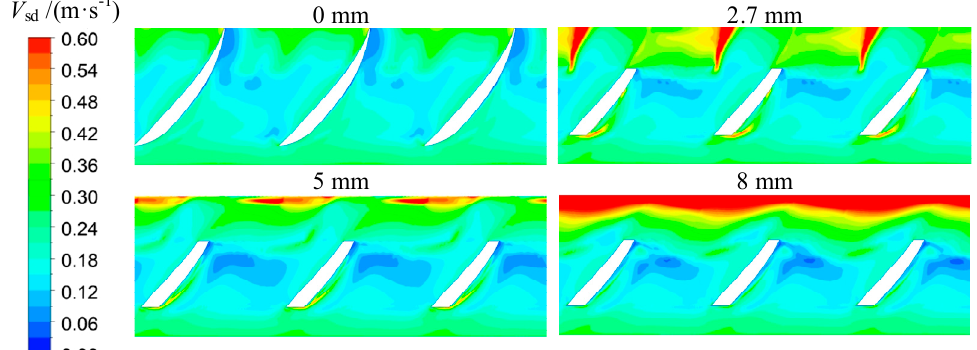
Figure 14. Standard deviation of the velocity distribution at Span = 0.015 in the impeller passage with varying root clearances ( R t = 0 mm, 2.7 mm, 5 mm, 8 mm; Q = 1.0 Q des ).